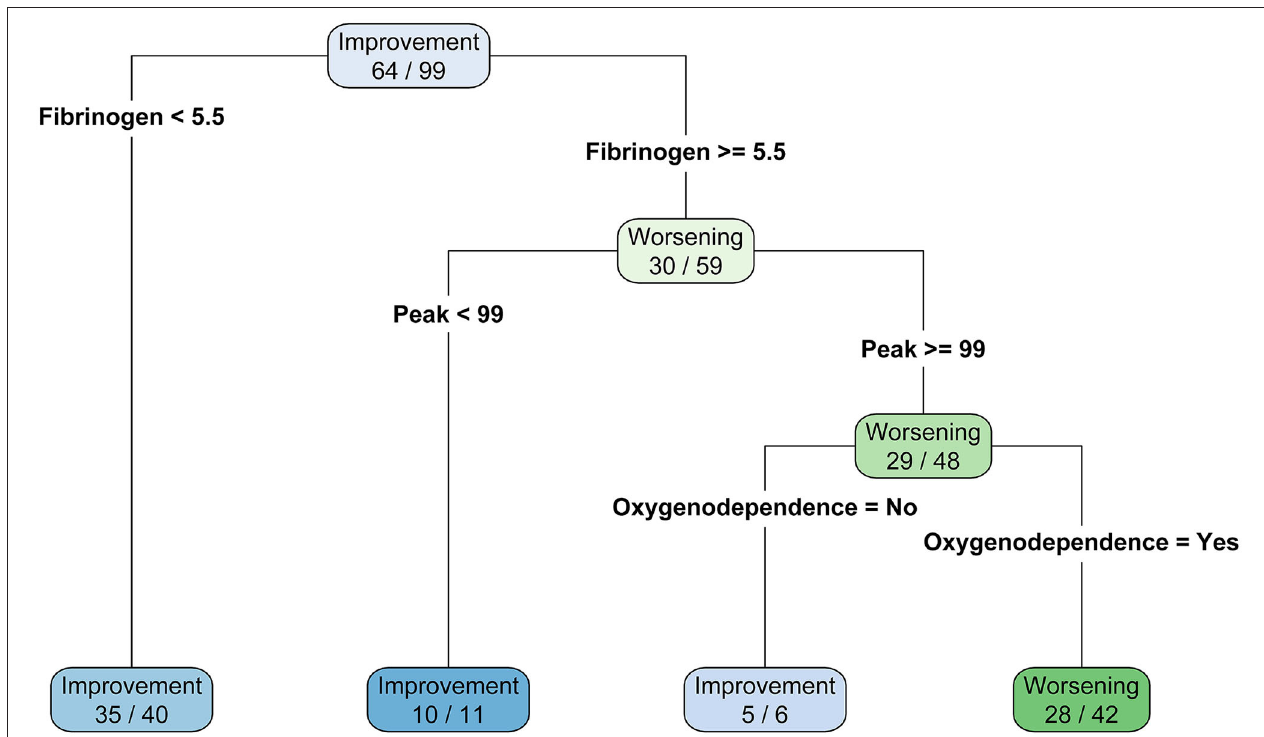
FIGURE 2 | Classification three of clinical status according to final logistic model